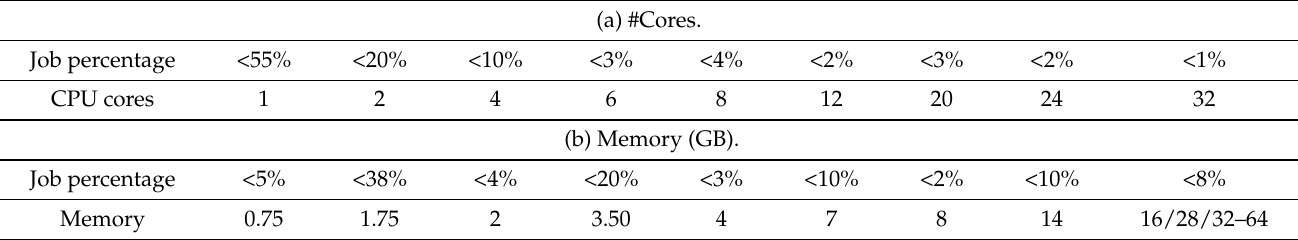
Table 3. Resource requirements